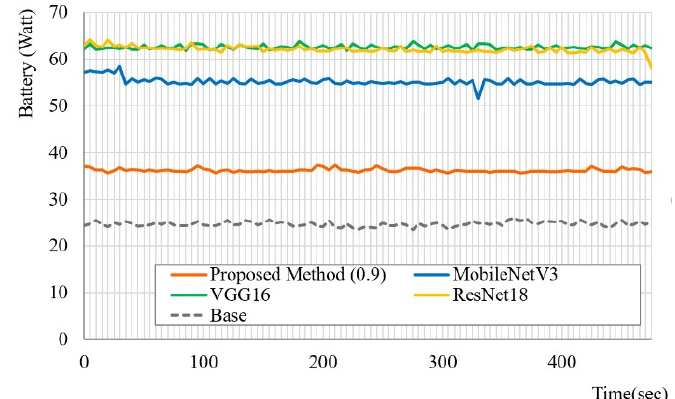
Figure 4. Comparison of battery discharge between our proposed method and CNN-based algorithms with GI4E dataset. “Base” is basically the amount of battery consumed by the OS and other basic utilities.